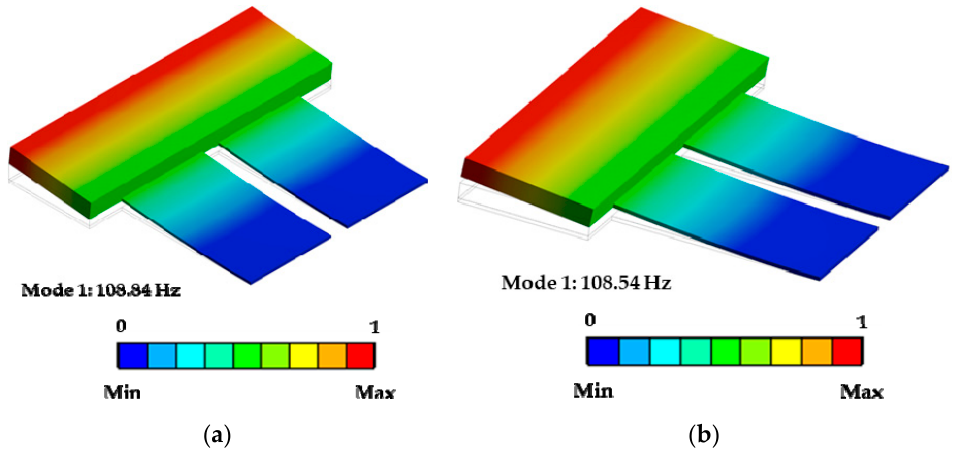
Figure 5. First bending vibration mode with a normalized amplitude of the PEH devices of ZnO ( a ) and PZT-5A-based PEH devices ( b ).